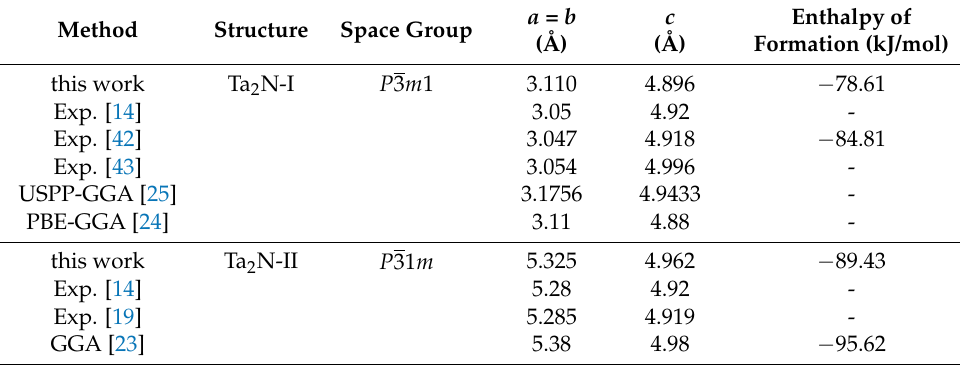
Table 2. The calculated lattice parameters (Å) and enthalpies of formation E f (kJ/mol) of Ta 2 N-I and Ta 2